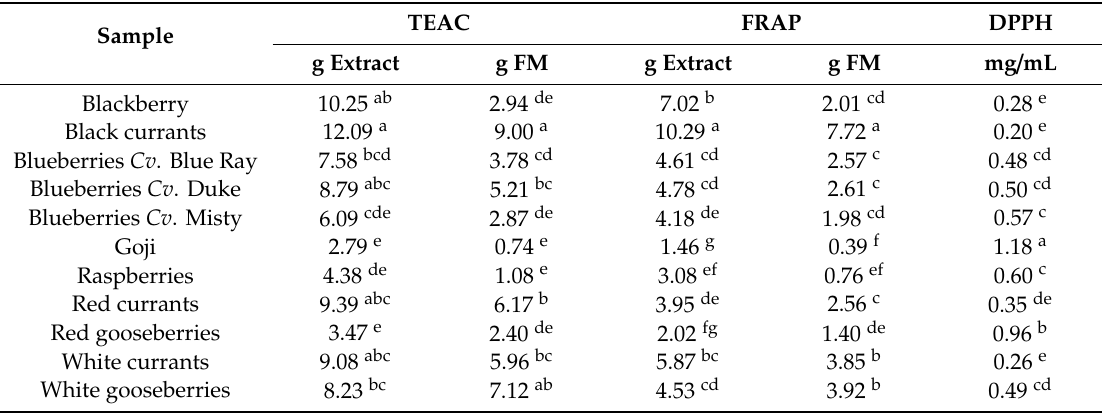
Table 3. Trolox equivalent antioxidant capacity (TEAC; mmol Trolox eq. / g), ferric-reducing antioxidant power (FRAP; mmol Fe 2 + / g), and radical scavenging activities against 2,2 (cid:48) -diphenyl-1-picrylhydrazyl